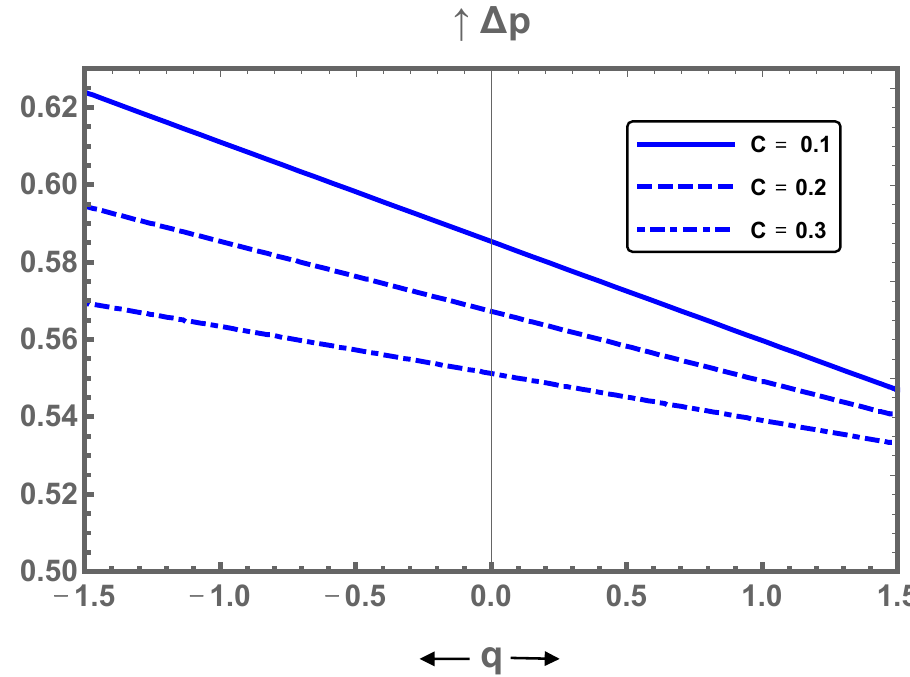
Figure 24. Display of pressure rise vs . volume flow rate for different values of C .